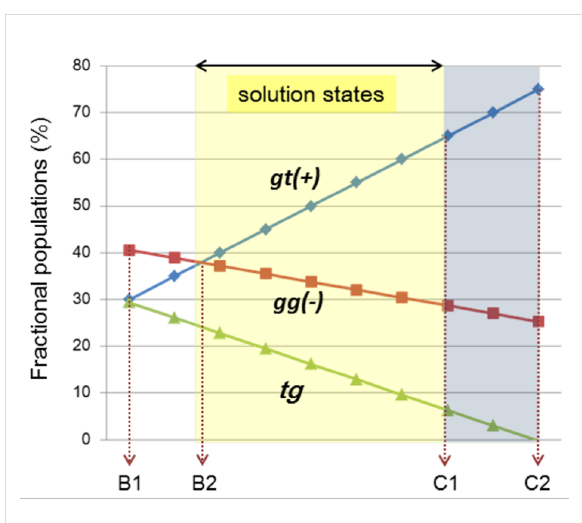
Figure 6: An empirical diagram showing helical conformational proper- ties around 1,2-diacyl moiety in asymmetric 1,2-dipalmitoyl- sn -glyc- erols in solution